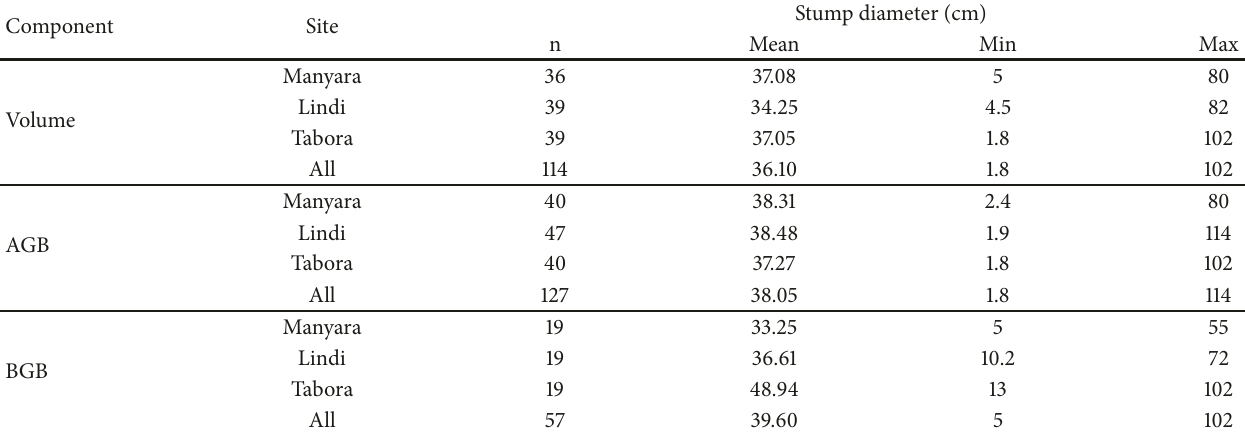
Table 2: Stump diameter descriptive statistics of volume, above- and belowground biomass